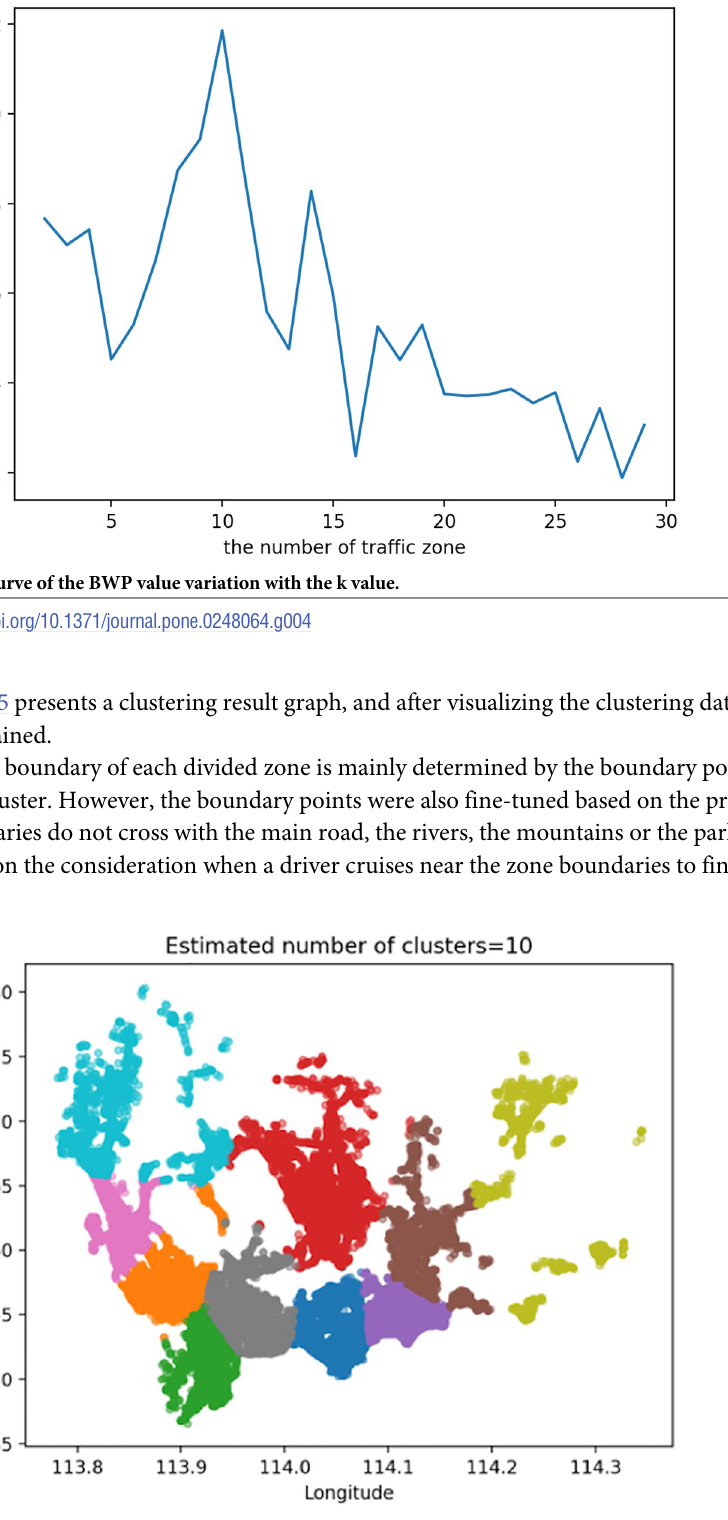
Fig 5. Clustering result graph with k =